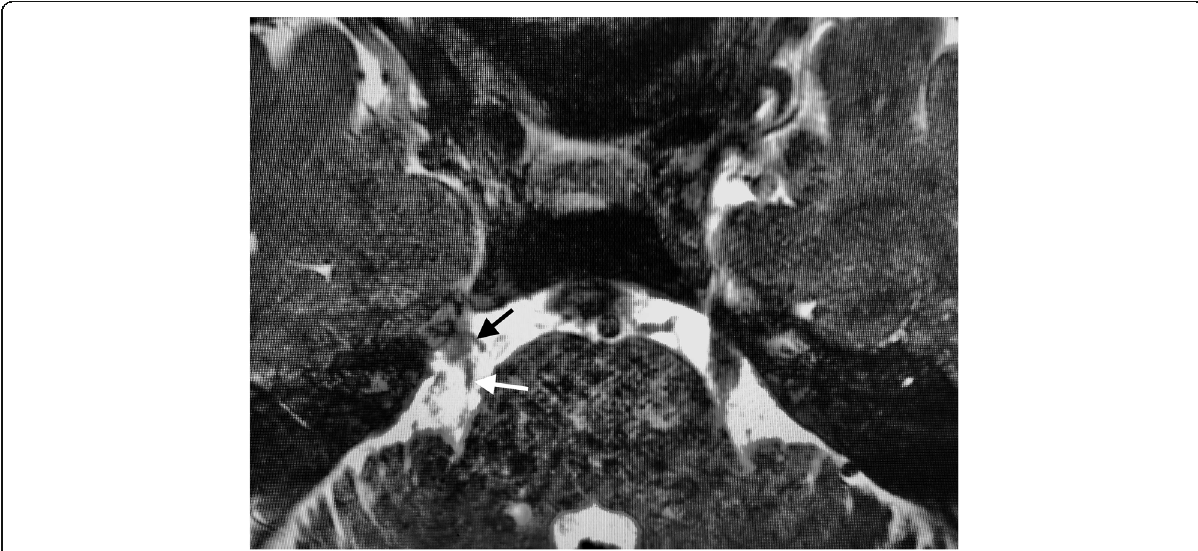
Fig. 1 Axial magnetic resonance imaging with a sequence of constructive interference in steady state showing that the right trigeminal nerve was in contact with multiple vessels (white arrow: right superior cerebellar artery, black arrow; right petrosal